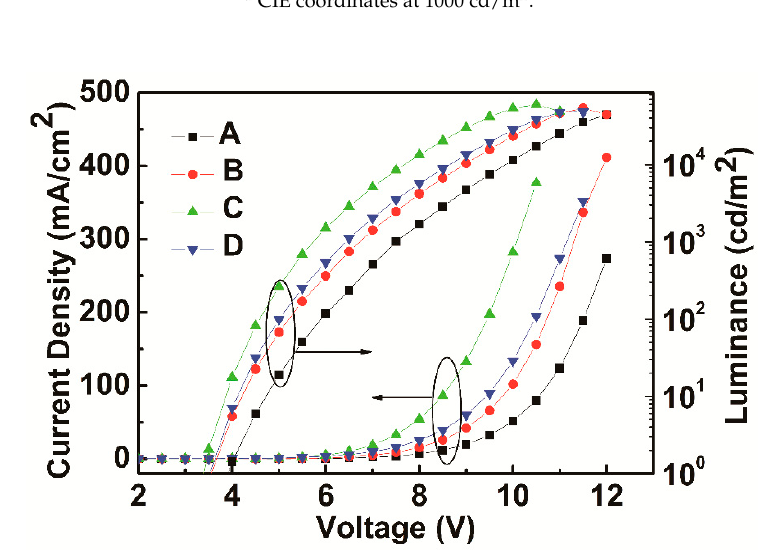
Figure 4. The current density-voltage-luminance characteristics of devices A–D.